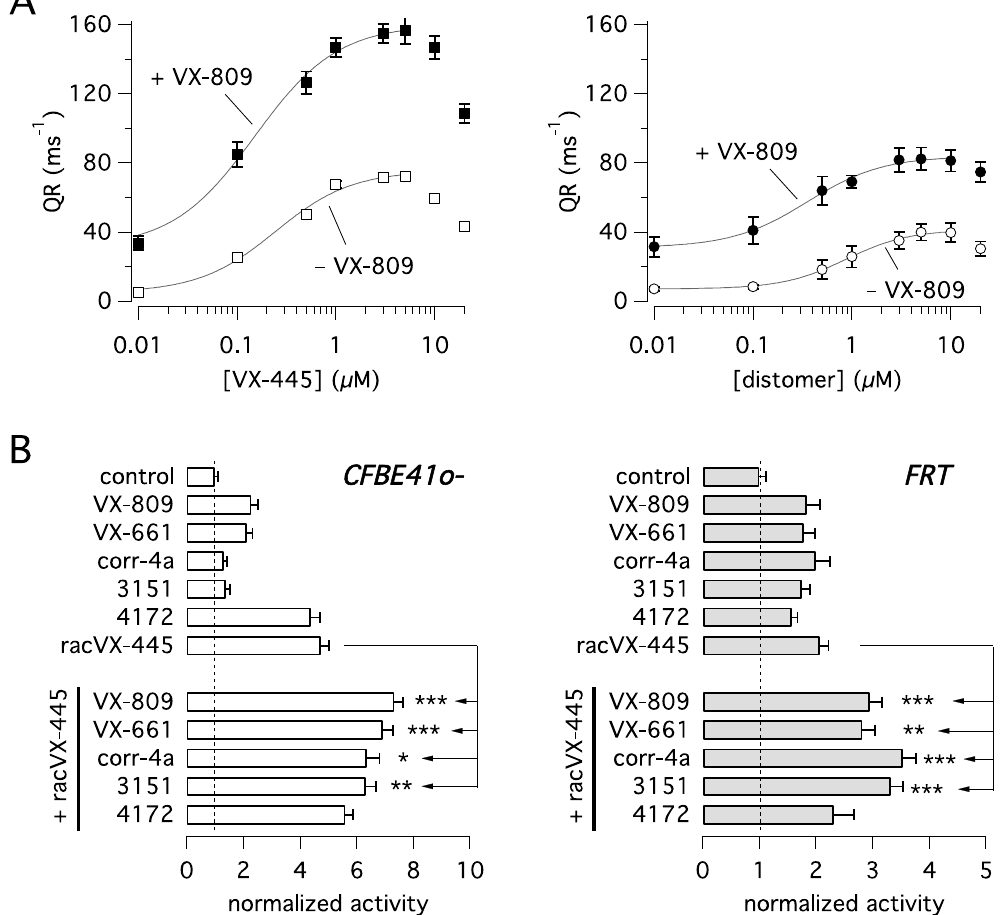
Figure 1. Functional evaluation of VX-445 corrector activity in heterologous expression systems. Compounds were tested on CFBE41o- and FRT cells expressing F508del-CFTR and the halide-sensitive yellow fluorescent protein (HS-YFP). ( A ) Dose-responses relationships for VX-445 and its (R) -enantiomer (i.e., distomer), as single agents or in the presence of VX-809 (1 µ M) on CFBE41o- cells. ( B ) Evaluation of corrector combination. The graphs report F508del-CFTR activity in CFBE41o- (left) and FRT (right) cells treated with vehicle alone (DMSO) or VX-809 (3 µ M), VX-661 (10 µ M), corr-4a (5 µ M), 3151 (10 µ M), 4172 (10 µ M), racVX-445 (3 µ M), or their combinations. Symbols indicate statistical significance versus treatment with racVX-445 alone: *, p < 0.05; **, p < 0.01; ***, p <